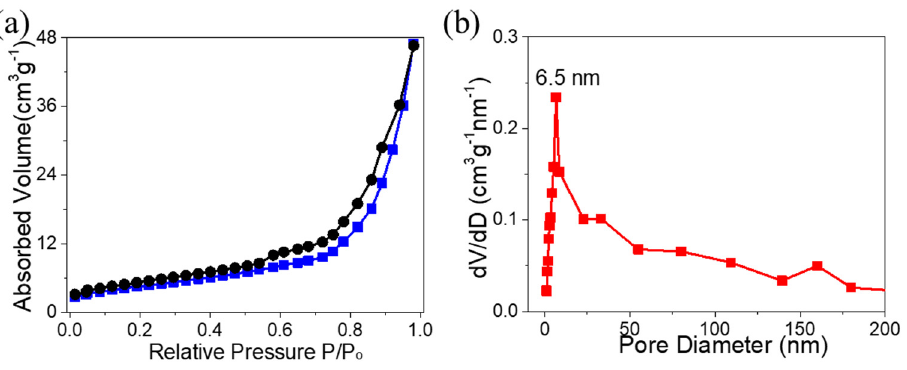
Figure 5. N 2 adsorption and desorption isotherms of ZnO nano-flowers ( a ) and pore-size distribu- tion of ZnO nano-flowers ( b ). of ZnO nano-flowers ( b ).